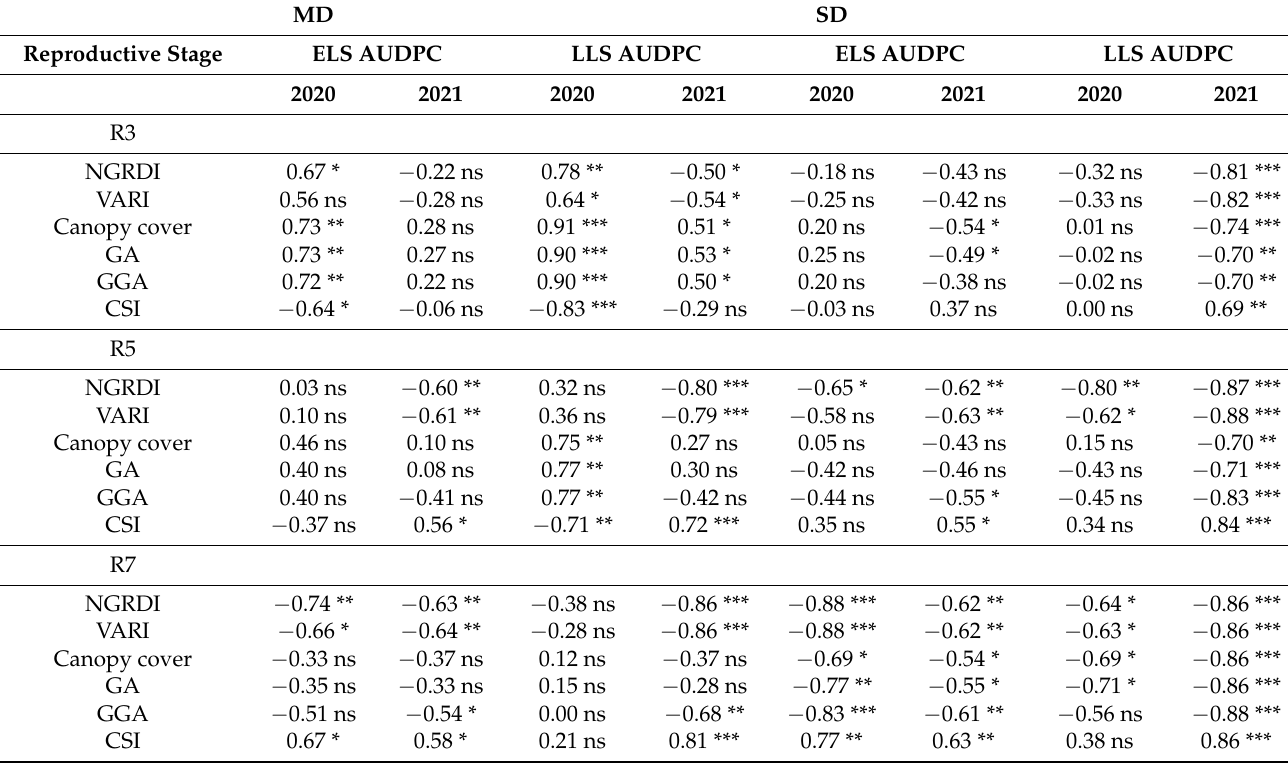
Table 4. Correlation between vegetation indices and